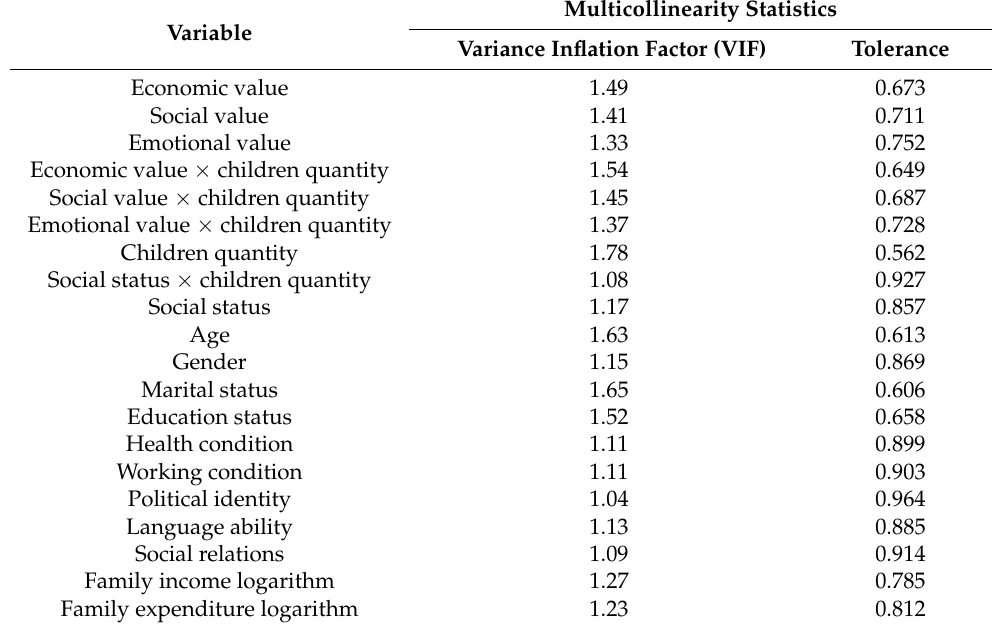
Table 2. Regression model